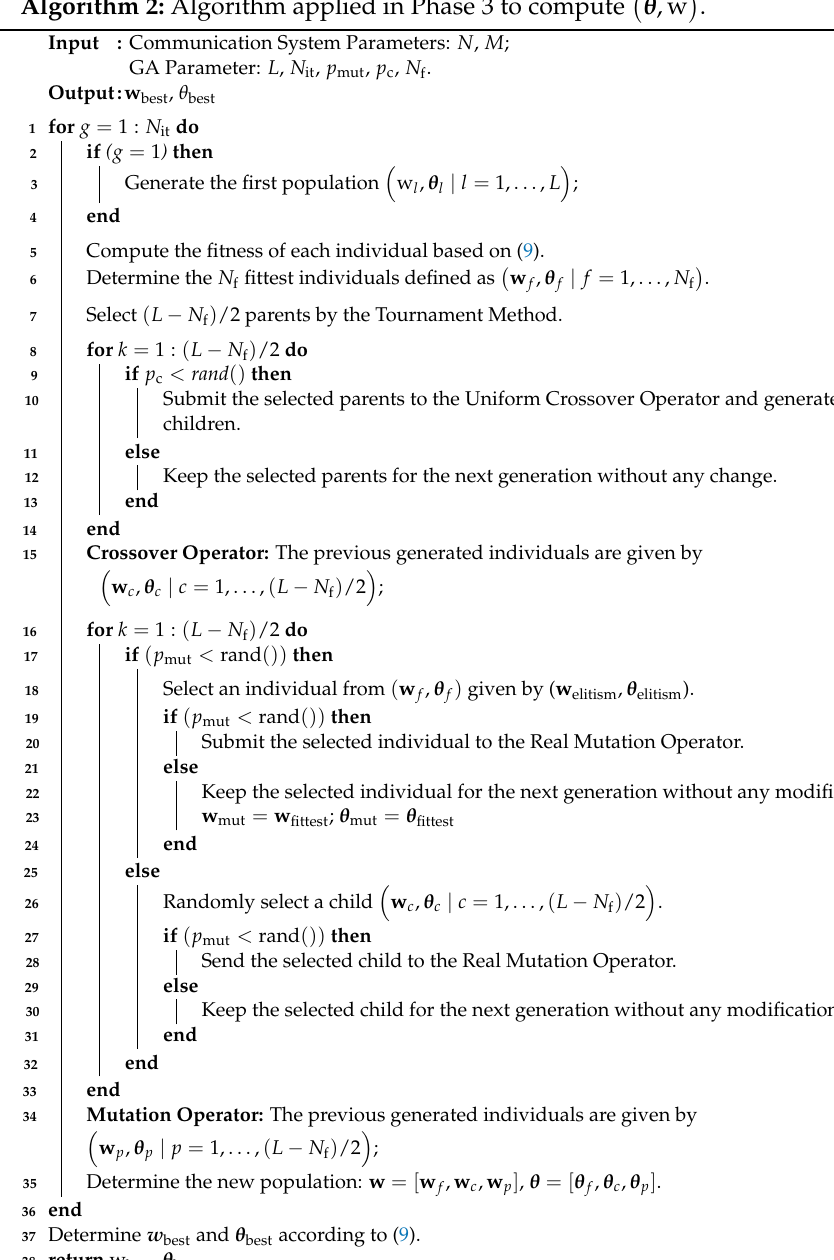
(cid:0) (cid:1) θ , w